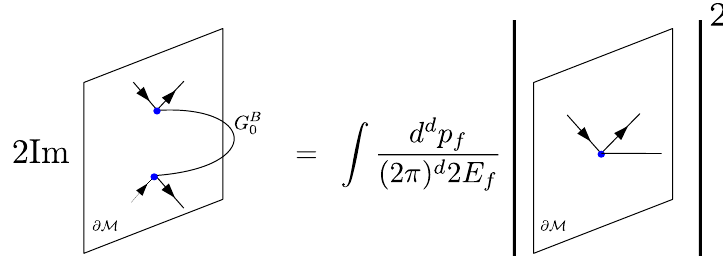
amplitude and its unitarity → ¯ΨΨ